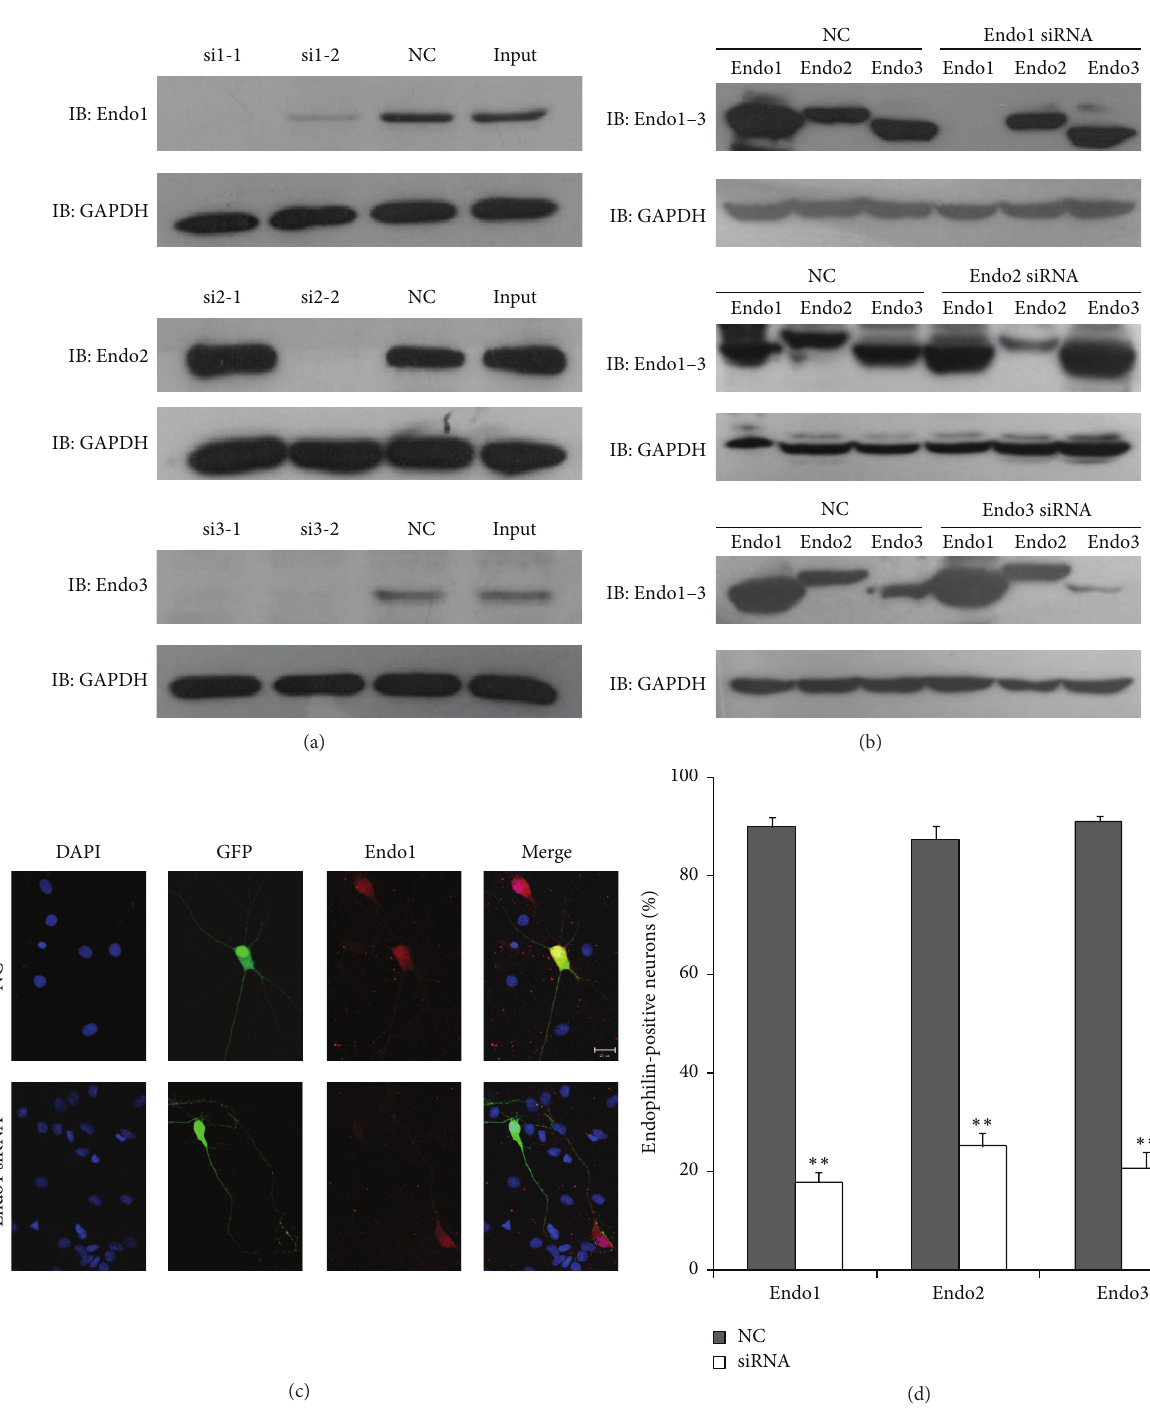
Figure 1: Efficacy and specificity of the designed siRNAs. (a) Immunoblotting detection of endophilin isoforms and GAPDH in HEK293 cells cotransfected with endophilin-pEGFPC1 plasmids and their corresponding siRNAs or negative control (NC). (b) Effect of each endophilin isoform-specific siRNA on the expression of other endophilin isoforms in HEK293 cells. (c) Neurons cotransfected with GFP (green) and NC or Endo1 siRNA. Cultures were stained using an endophilin1 antibody (red). Scale bar, 20 𝜇 m. (d) The percentages of endophilin-positive neurons with each treatment were quantified as the mean ± SEM of three independent experiments. ∗∗ 𝑝 < 0.005